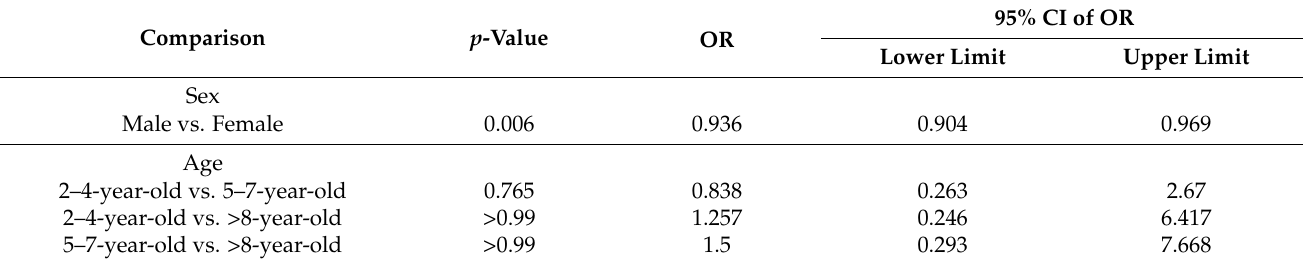
Table 2. Odds ratio (OR), confidence interval (CI) of OR, and p -value for the pairwise comparison of horses with and without equine parvovirus-hepatitis (EqPV-H) infection according to sex and age. For statistical analysis based on sex, stallions and geldings were grouped as male and EqPV-H-negative horses were compared with EqPV-H-positive horses. For statistical analysis based on age, EqPV-H-negative horses were compared with EqPV-H-positive horses. 95% CI of OR Comparison p -Value OR Lower Limit Upper